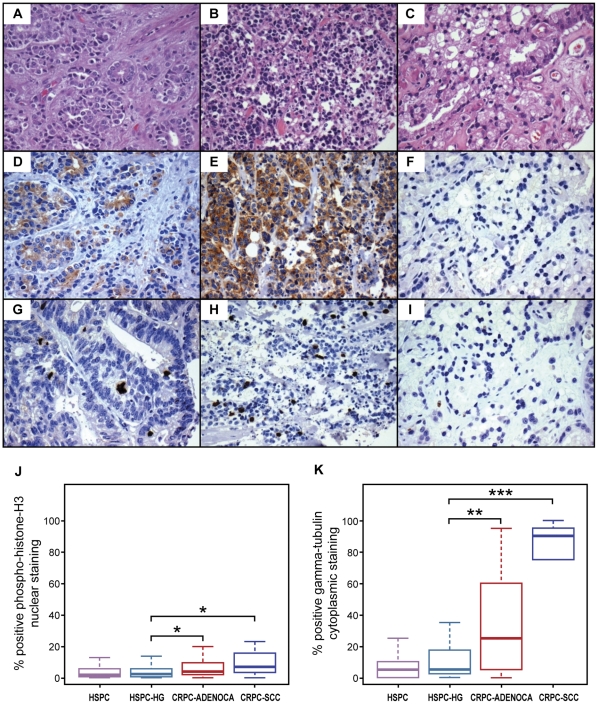
Increased mitosis-phase and centrosomal protein expression in castration-resistant prostate cancer compared with high-grade hormone-sensitive prostate cancer.Hematoxylin and eosin (H&E)-stained sections showing castration-resistant adenocarcinoma (A), castration-resistant small cell carcinoma (B), and hormone-sensitive high-grade prostate carcinoma (C). Castration-resistant adenocarcinoma immunostained with gamma tubulin (D) and p-histone H3 (G). Castration-resistant small cell carcinoma immunostained with gamma tubulin (E) and p-histone H3 (H). Hormone-sensitive high-grade prostate carcinoma immunostained with gamma tubulin (F) and p-histone H3 (I). Asterisks indicate significantly increased labeling for the mitosis-phase marker p-histone H3 (J) and centrosomal marker gamma-tubulin (K) in castration-resistant prostate carcinoma compared to hormone-sensitive high-grade prostate carcinoma.